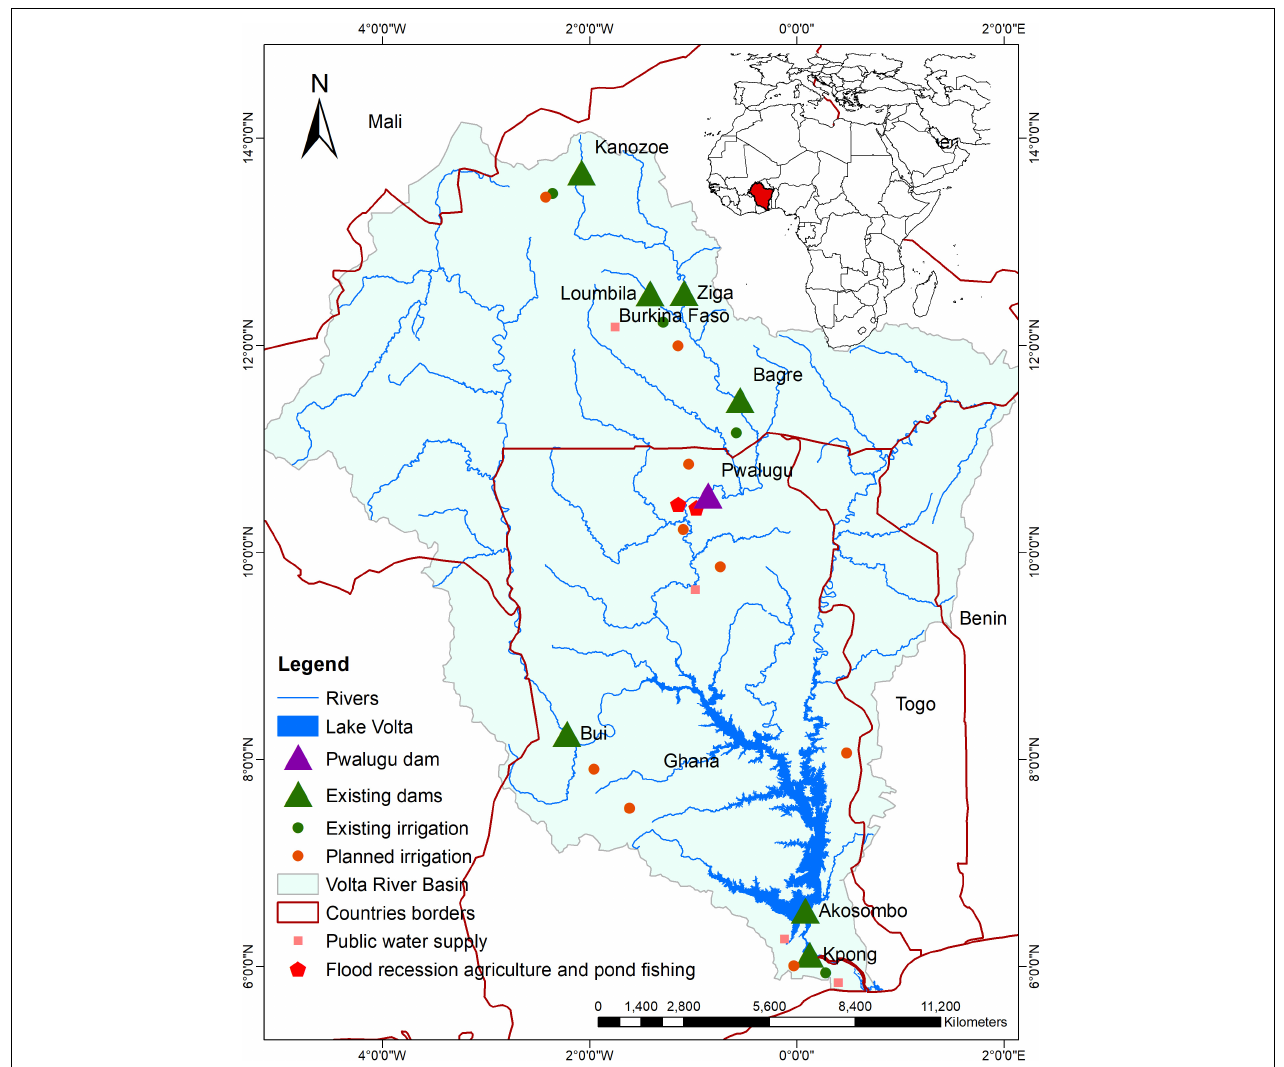
FIGURE 1 | Volta river basin. Location of infrastructure in the six-country river